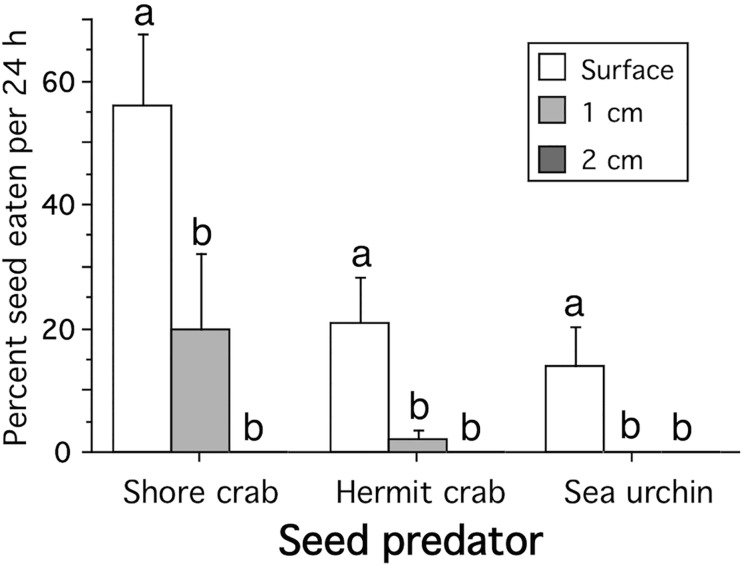
Seed burial depth and predation.Seeds consumed per day (mean+SE) by three potential seed predator species as a function of burial depth. Different letters above bars denote significant different means between sediment treatments (SNK-test at P<0.05).